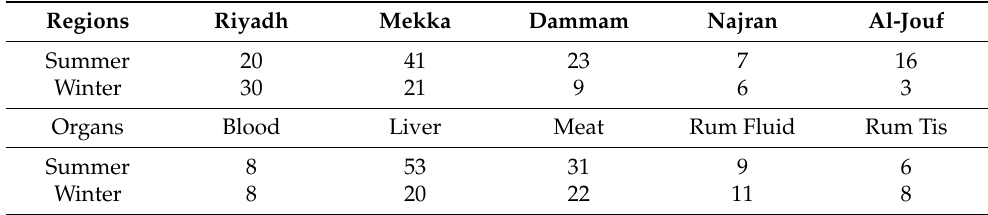
Table 3. Distribution of the samples according to seasons and